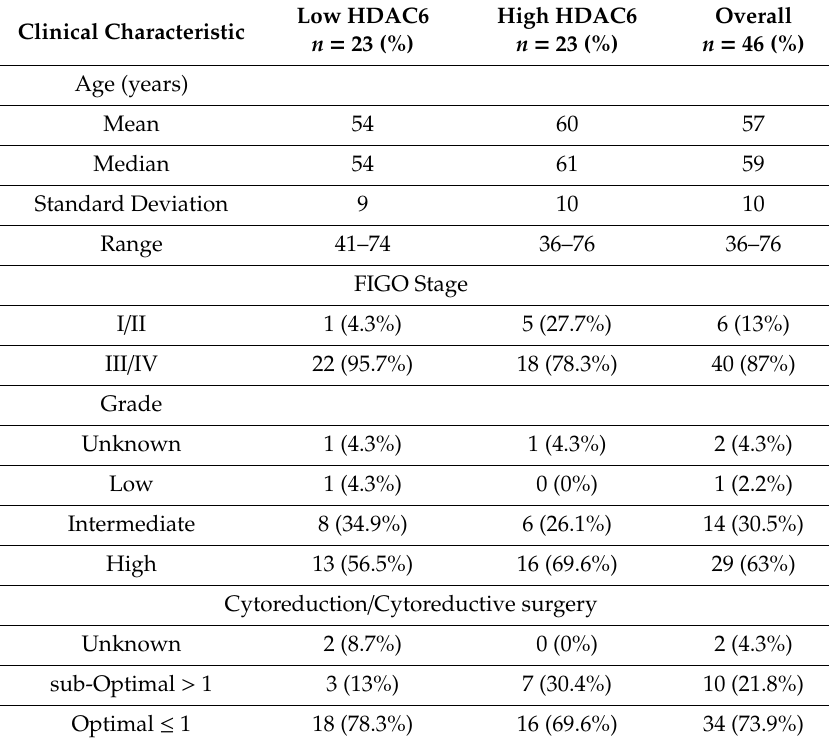
Table 1. Clinical characteristics of ovarian cancer cases included in this